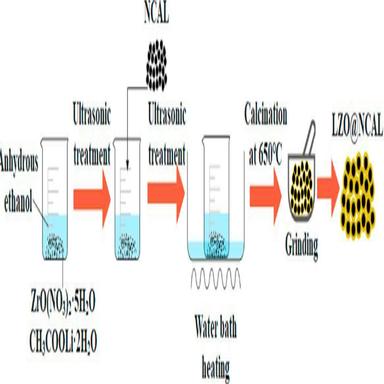
The schematic of synthetic procedure for 1 wt % LZO@NCAL.